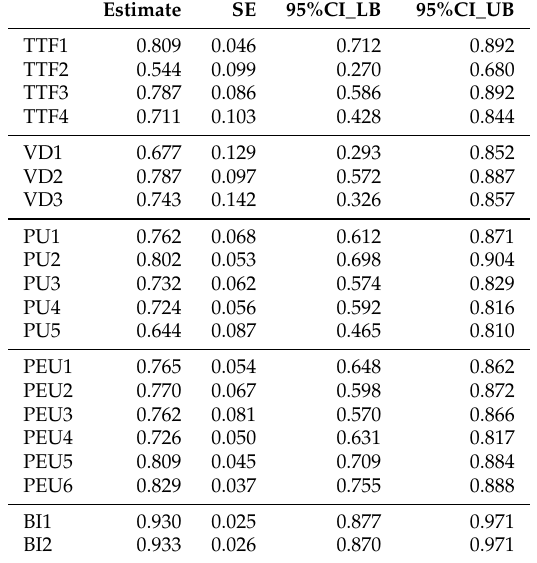
Table 5. Estimates of loadings.